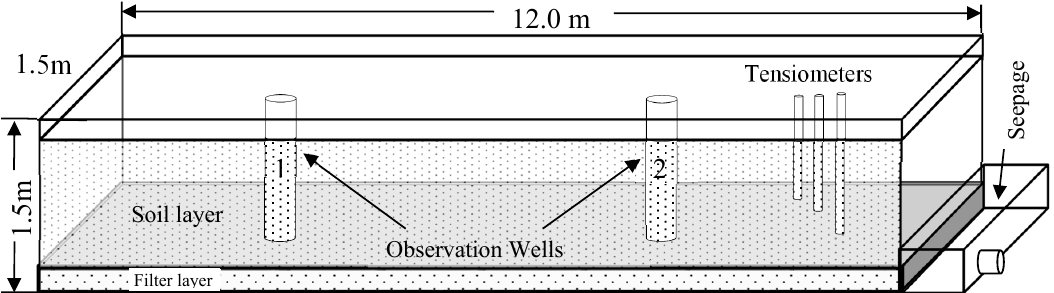
Figure 2. Sketch of the rainfall–runoff experiment in the soil tank as well as the position of measuring instruments.